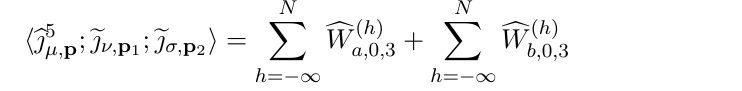
| 5 ; | (cid:23); p ; | (cid:27); p i b e e (cid:22); p 1 2